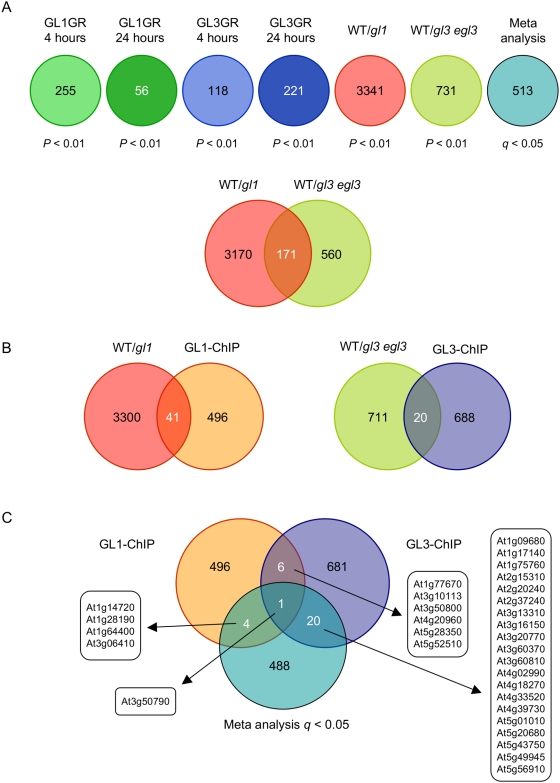
Genome-wide expression changes induces by GL3 or GL1.(A) Venn diagram representation of the genome-wide alterations in mRNA accumulation in gl1 pGL1::GL1-GR plants induced 4 (GL1GR 4 hours) or 24 hrs with DEX (GL1GR 24 hours), gl3 egl3 pGL3::GL3-GR plants induced 4 (GL1GR 4 hours) or 24 hrs with DEX (GL1GR 24 hours), differentially expressed genes between wild type and the gl1 mutant (WT/gl1) or between wild type and the gl3 egl3 mutant (WT/gl3 egl3). Numbers inside the diagrams represent the total umber of genes affected at the indicated P value. Genes estimated to be affected by GL1 and GL3, forming a minimal “Trichome genes” set, were deduced using a meta-analysis statistical approach (see Materials and Methods). (B) Venn diagrams indicate the number of genes that were affected by two or more of the contrasts described in (A). (C) Overlap between gene expression and ChIP-chip analyses. The AGI numbers for the genes in each intersection are indicated.